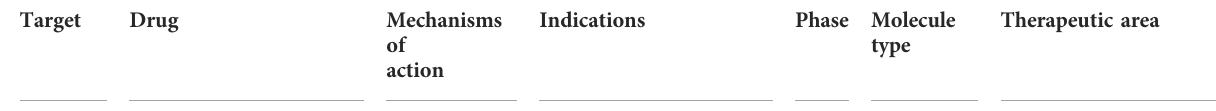
(Table 1) of which six targets overlap with PPI network top genes including ICAM1, PTGS2, CXCL10, ITGAL, NCAM1, SERPINE1 (Figure 4). Based on the association to top